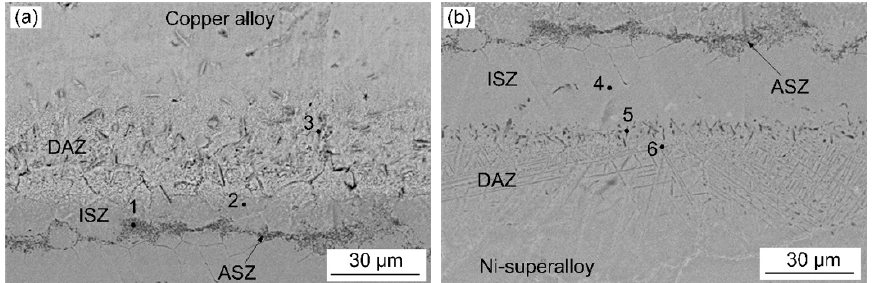
Figure 4. SEM micrographs of the copper side ( a ) and superalloy side ( b ) of a joint bonded for 60 min and the locations of EDS analyses . Table 2. Chemical composition (wt. %) of various locations marked 1 to 6 in Figure 4.